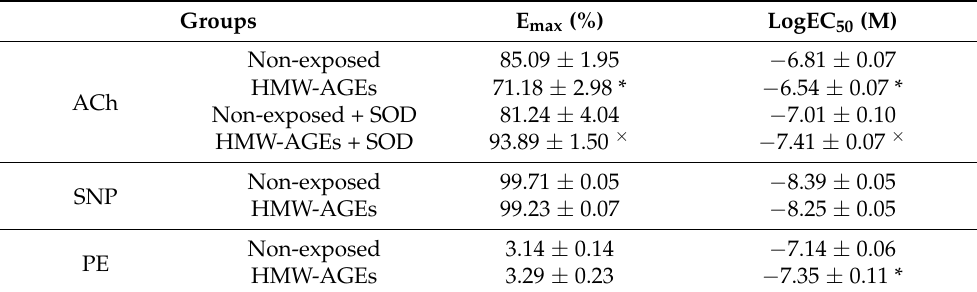
Table 1. E max and logEC 50 values in isolated rat aortic rings .